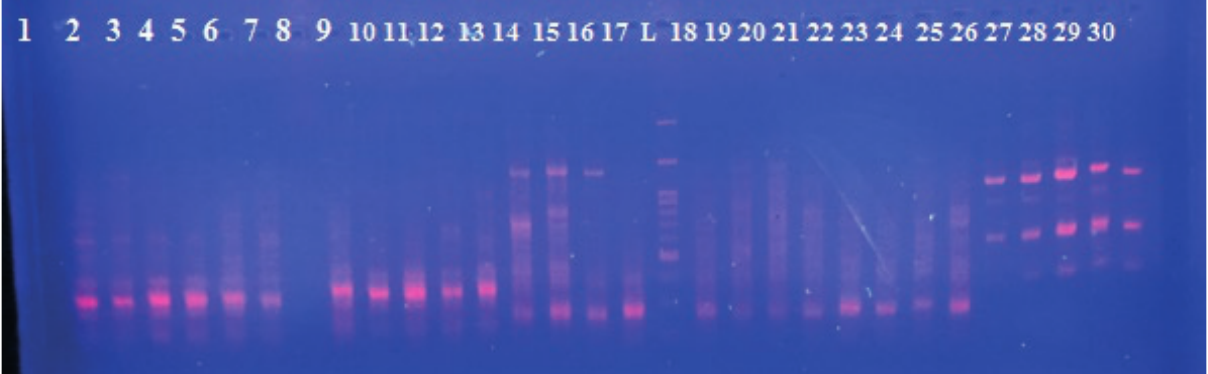
Figure 2. Electrophoresis gel of Pistacia vera species from DNA fragments produced by SCoT-11 molecular markers, (Population numbers are according to Table